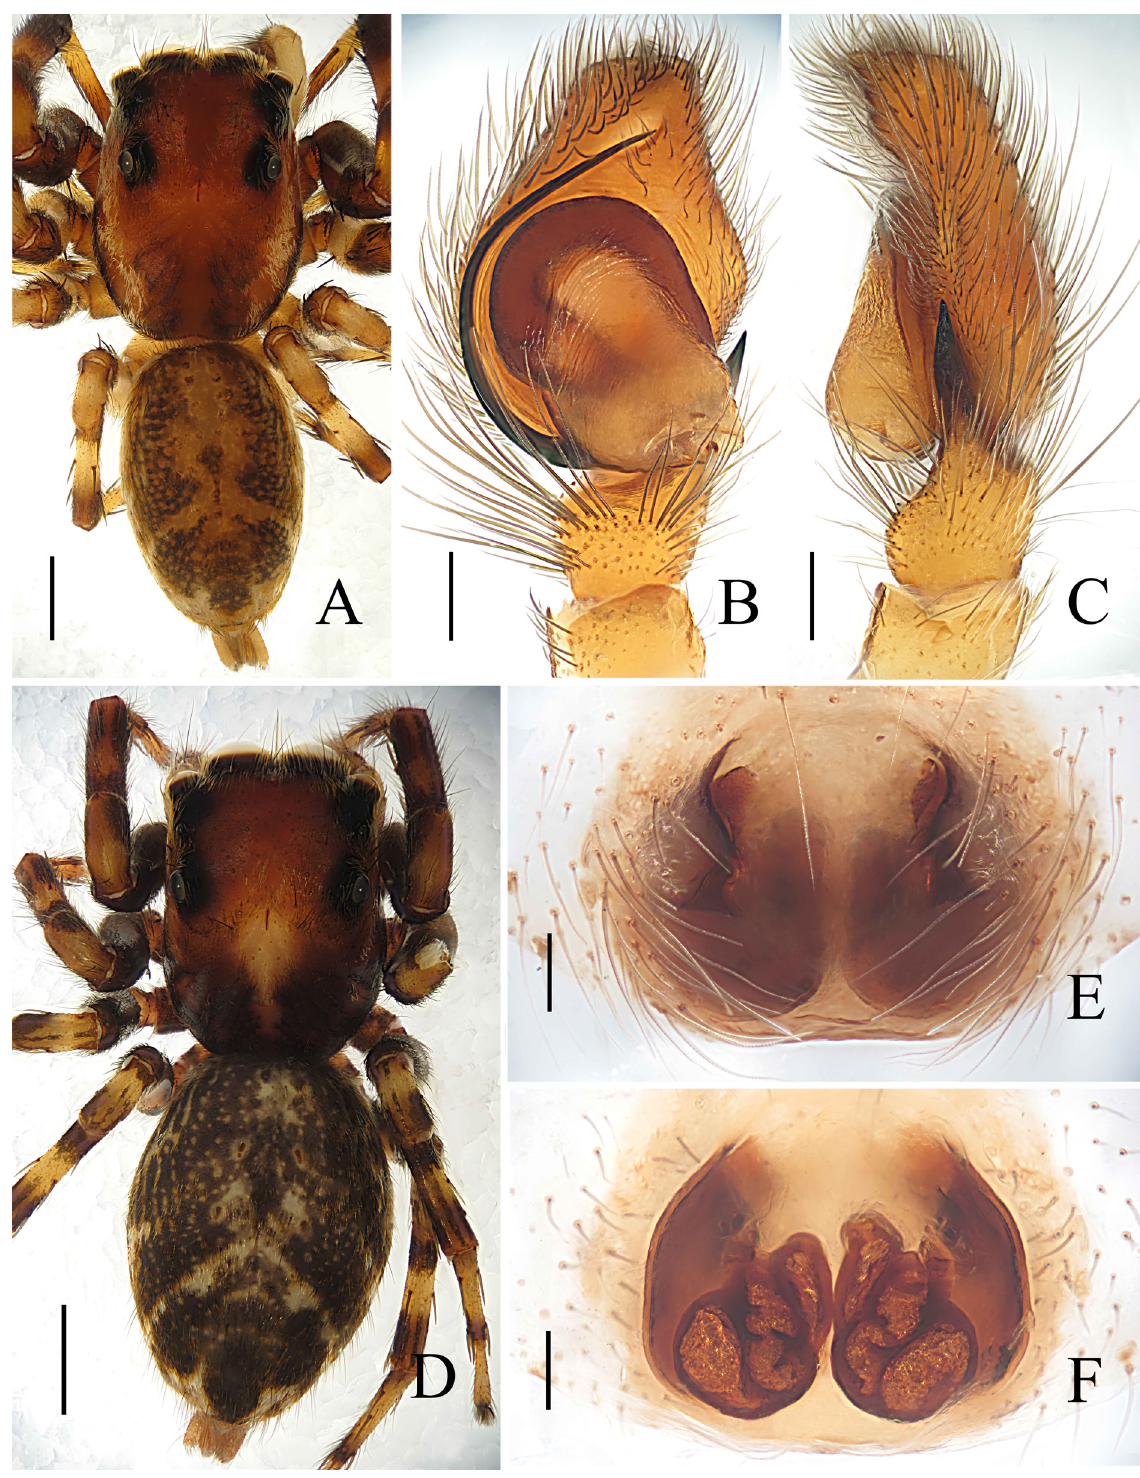
Fig. 4. Yaginumaella hubeiensis sp. nov. A – C . Holotype, ♂ (HNU-HB-IV-1626). D – F . Paratype, ♀ (HNU-HB-IV-1624). A . Male body, dorsal view. B . Male palp, ventral view. C . Male palp, retrolateral view. D . Female body, dorsal view. E . Epigyne, ventral view. F . Vulva, dorsal view. Scale bars: A, D = 1 mm; B–C, E–F = 0.2